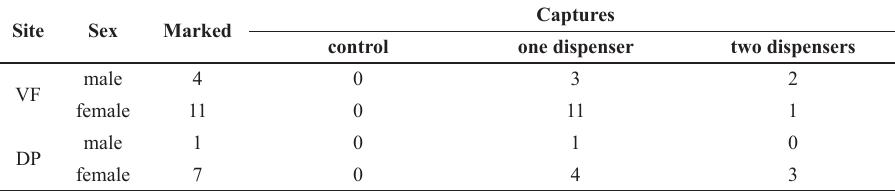
Table 2. Dataset of mark recapture during 2014. Summary of capture-mark-recapture data of O. eremita obtained during 2014 in PA (PA = Parco Nazionale d’Abruzzo Lazio e Molise; VF = Val Fondillo; DP = Difesa di Pescasseroli).